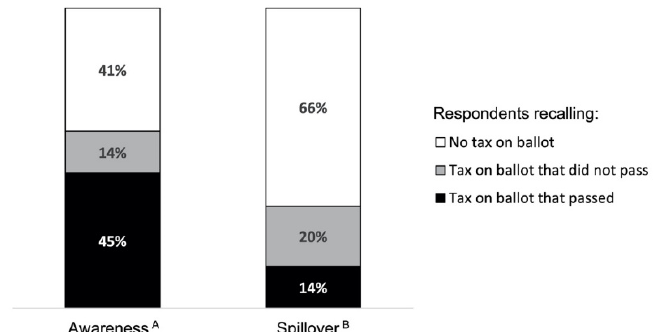
Figure 2. Unadjusted percentage of respondents correctly (Awareness) and incorrectly (Spillover) recalling passage of a tax in prior year. A In cities where a tax passed via ballot measure in prior year: Berkeley (2015, N = 555), Oakland (2017, N = 656), and San Francisco (2017, N = 593). B In cities where a tax was not on the ballot in prior year: Oakland (2015, N = 472) and Richmond (2017, N = 617).